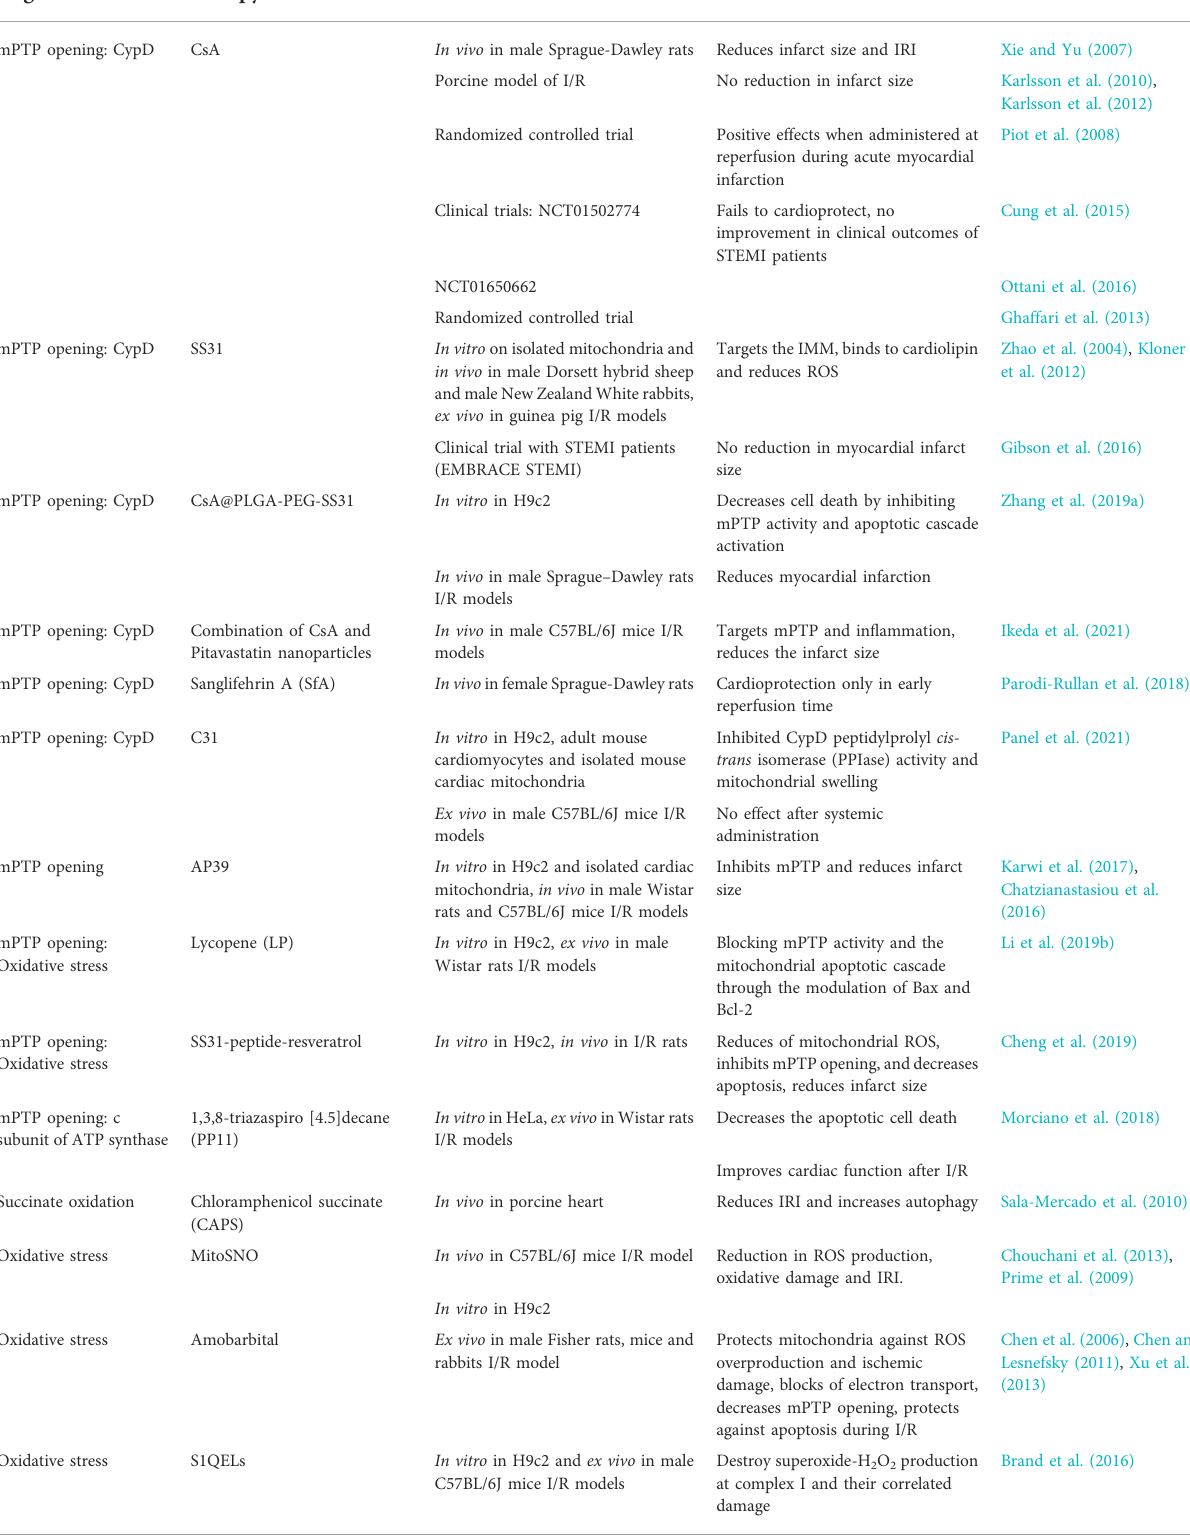
TABLE 1 Summary of recent therapies based on targeting mitochondria in